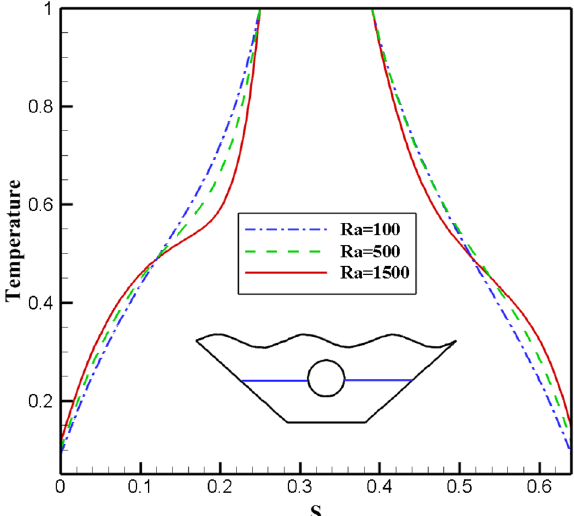
Figure 13. Temperature plot for different Ra numbers.